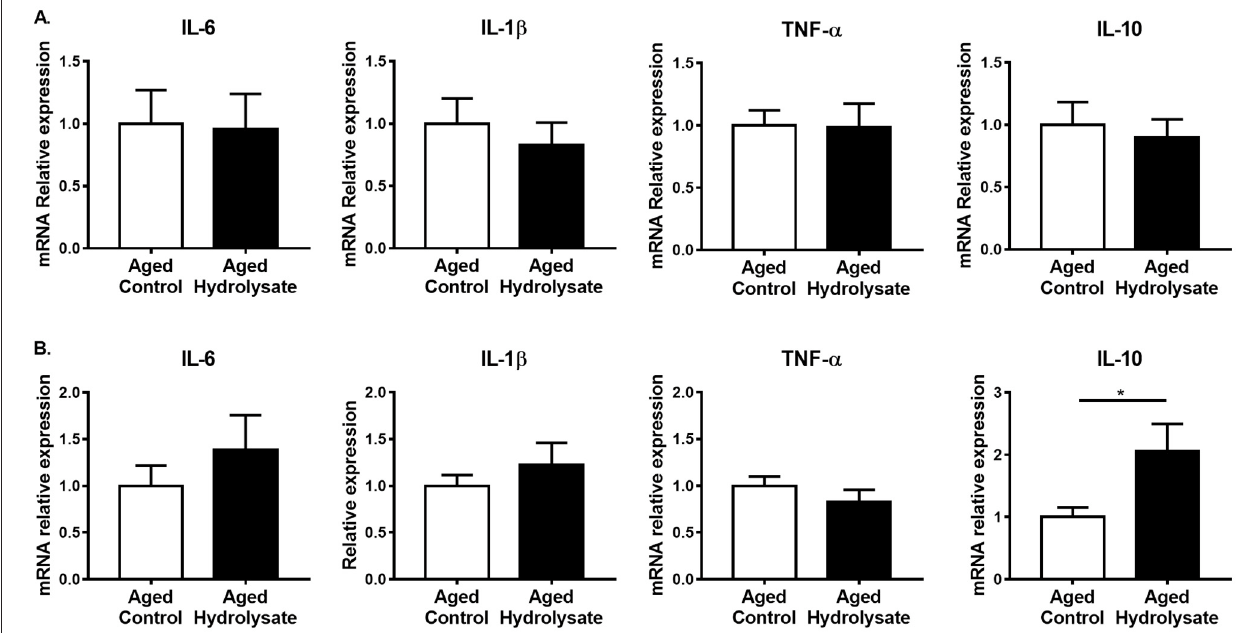
FIGURE 8 | Effects of the fish hydrolysate supplementation on intestinal inflammation. Pro-inflammatory cytokines IL-6, IL-1 β , and TNF- α and anti-inflammatory cytokine IL-10 mRNA expressions in (A) the ileum and (B) the colon of aged mice fed with the control diet or the hydrolysate-enriched diet for 10 weeks (* p < 0.05 by unpaired t -test; n = 8 per group). Data are presented as mean ± SEM.